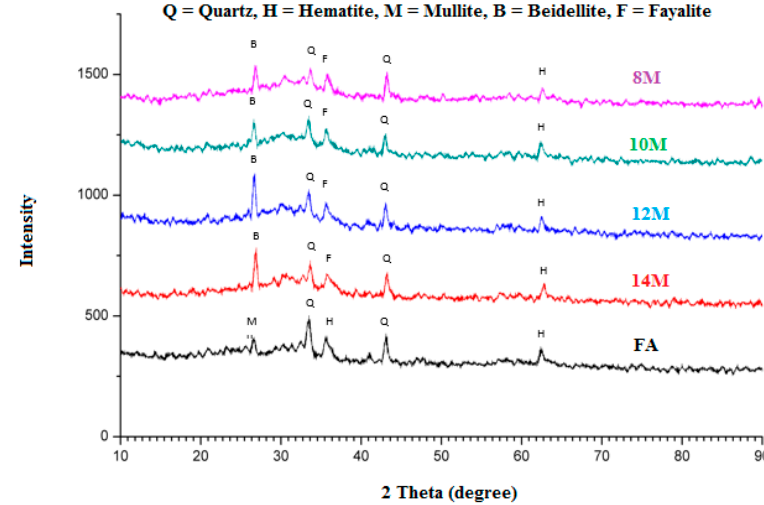
Figure 8. X-ray diffraction (XRD) analysis of precursor and FA-based geopolymer paste with various NaOH Molarity. Q = quartz (SiO 2 : PDF = 01-079-1911), B = beidellite ((Na,Ca)Al 2 Si 4 O 10 (OH) 2 ; PDF = 00-058 2019); F = fayalite (Fe 2 SiO 4 : PDF = 00-034-0178), H = hematite (Fe 2 O 3 : PDF = 00-033-0664),.